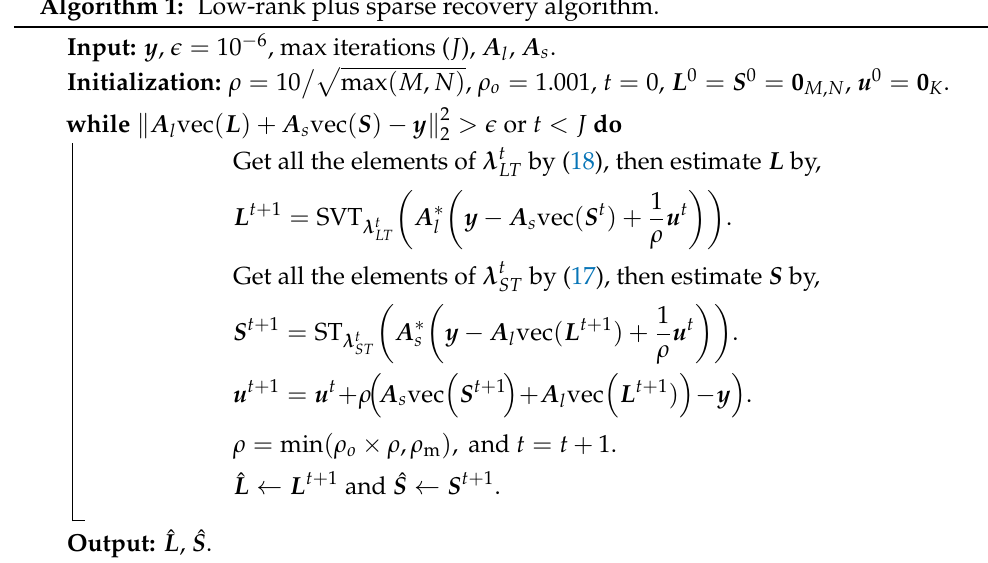
Figure 2. Block diagram of the t -th layer of the DNN which mimics the low-rank plus sparse recovery Algorithm 1. Weights of the linear layers ( W 1 , W 2 , W 3 , W 4 ) and other parameters ( λ t learned from training data. Algorithm 1: Low-rank plus sparse recovery